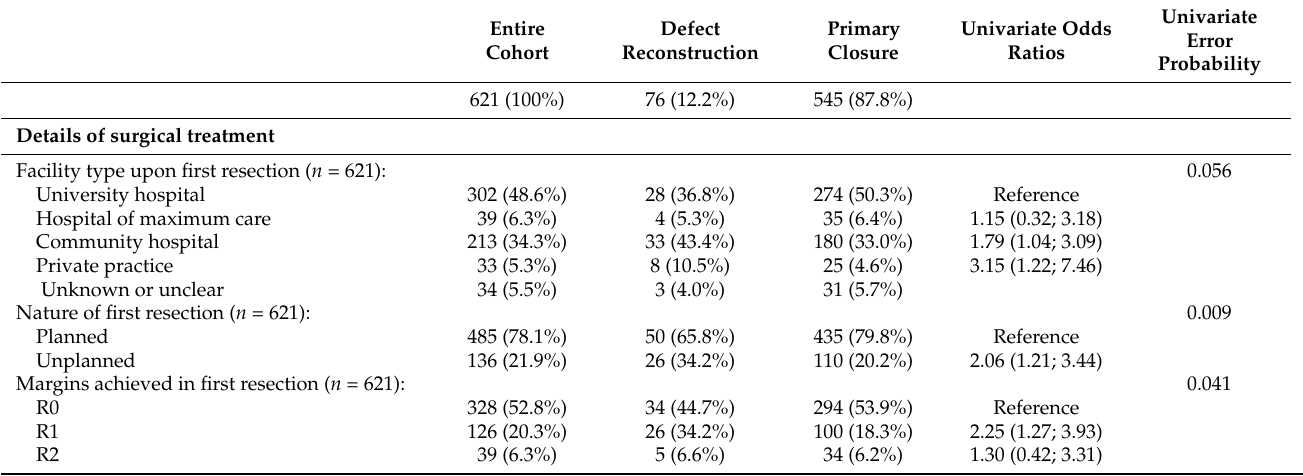
Table 4. Description of treatment